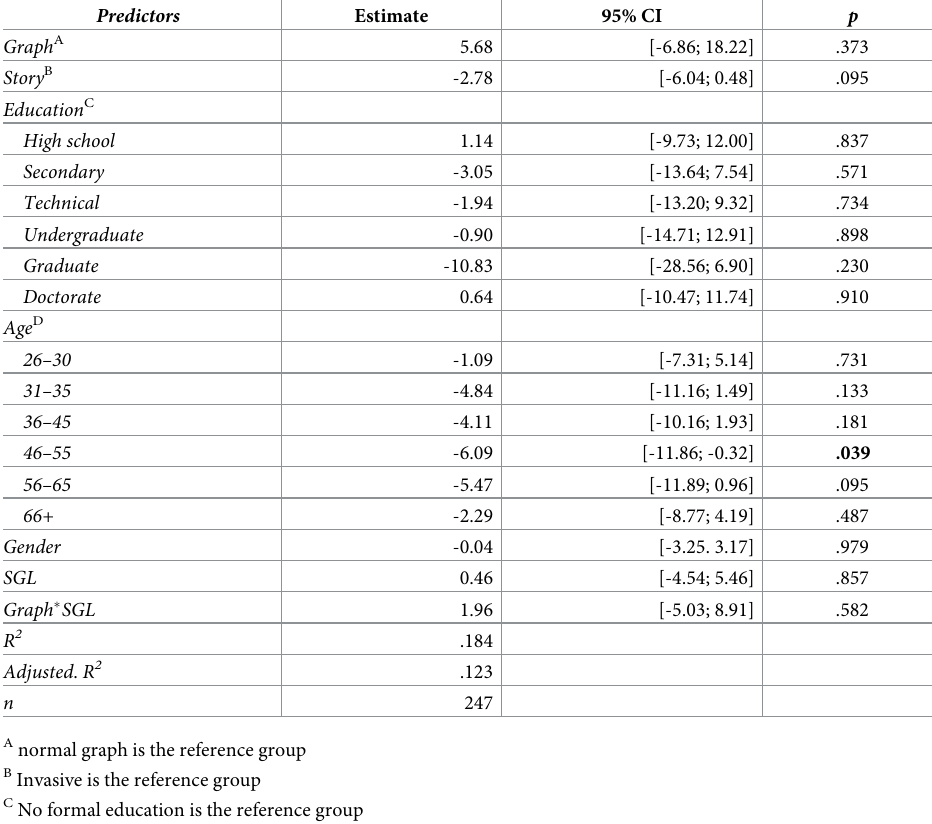
Table 4. Model summary for the multiple linear regression model with percentage as the dependent